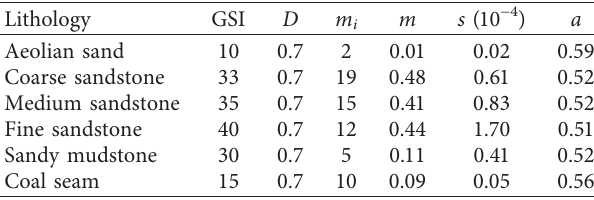
Table 3: Correlation parameter values of H-B criterion.